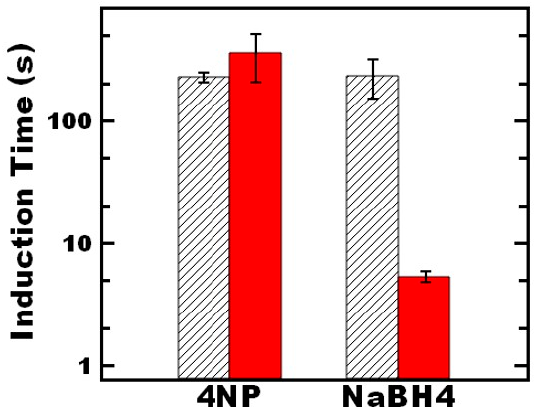
Figure 3. The effect of the sequence of reagent addition on the induction time of the 4-nitrophenol reaction. In all experiments, the 4-nitrophenol and sodium borohydride concentration followed standard conditions of 0.01 mM and 0.01 M, respectively. The indicated reagent was the first to be added, after which the reagent was allowed to equilibrate in the solution for either 1 min (black striped bars) or 10 min (red solid bars). The end of the equilibration period was the addition of the second reagent, at which point the reaction could progress.